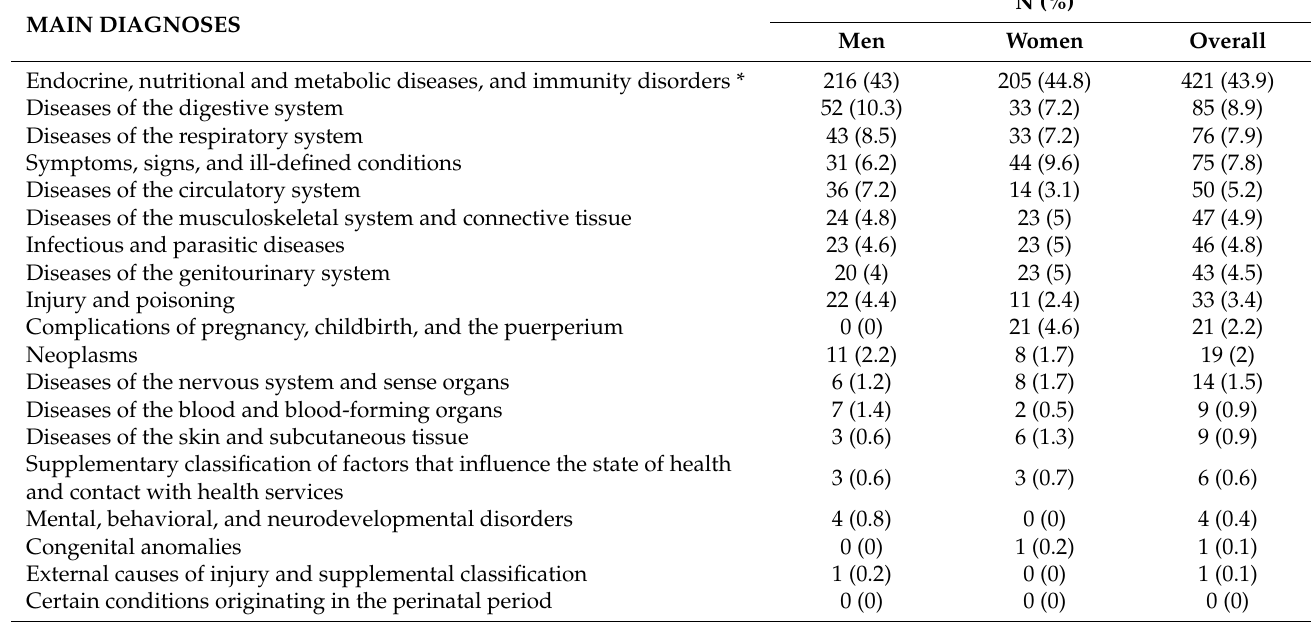
Table 2. Hospitalizations of patients with FMF, 2008–2015: main diagnoses according to ICD-9- MC